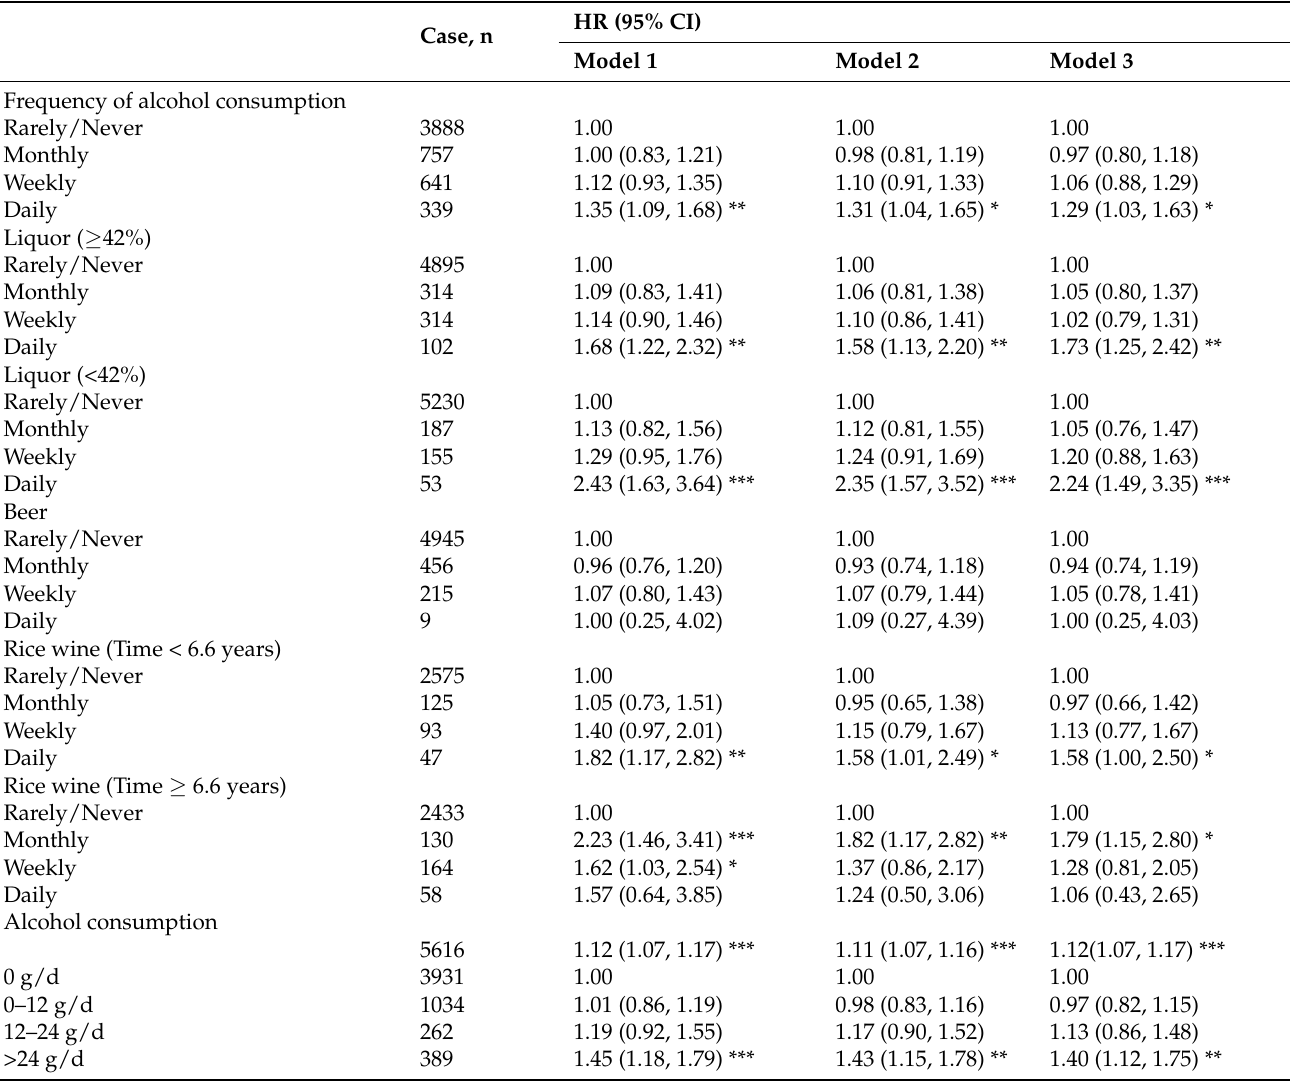
Table 2. Hazard ratios (95% confidence intervals) of hypertension associated with